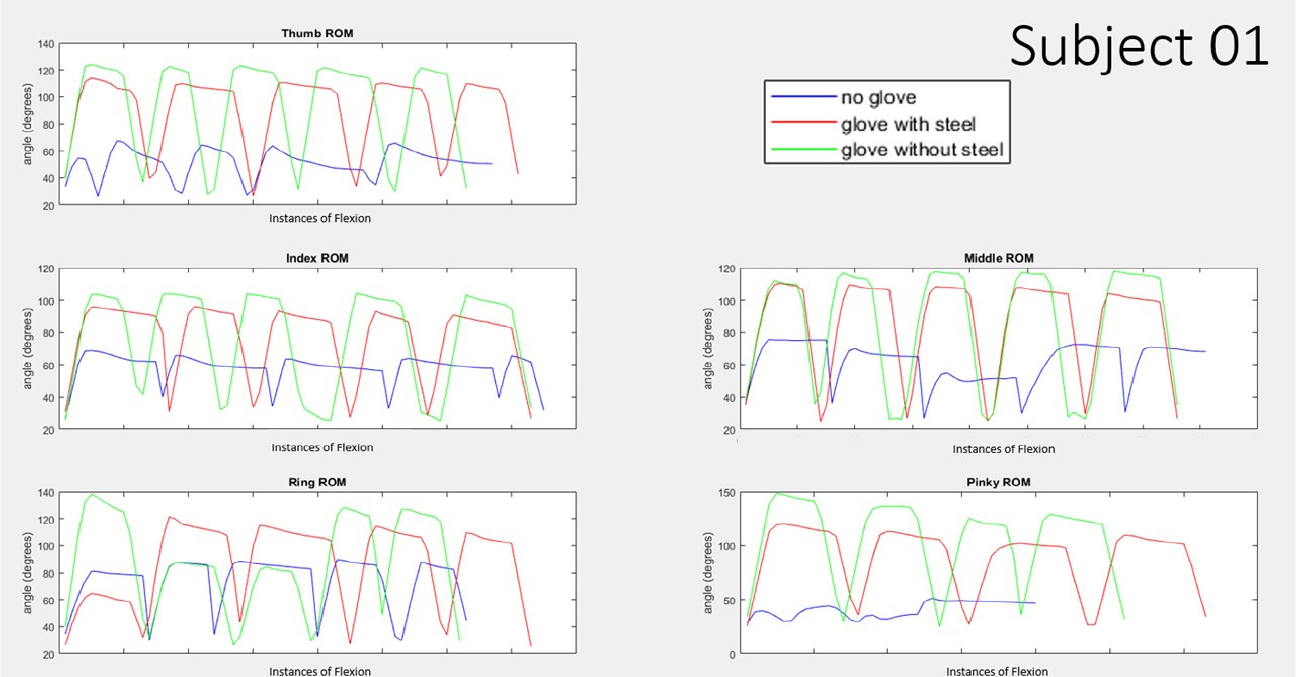
Figure 8. Range of Motion for 5 nonsequential instances of participant actuated finger curling with no pneumatic assistance for 3 different conditions of wearing no pneumatic glove (shown in blue), wearing the pneumatic glove with steel inserts (shown in red), and wearing the pneumatic glove without the steel (shown in green) for subject 01.